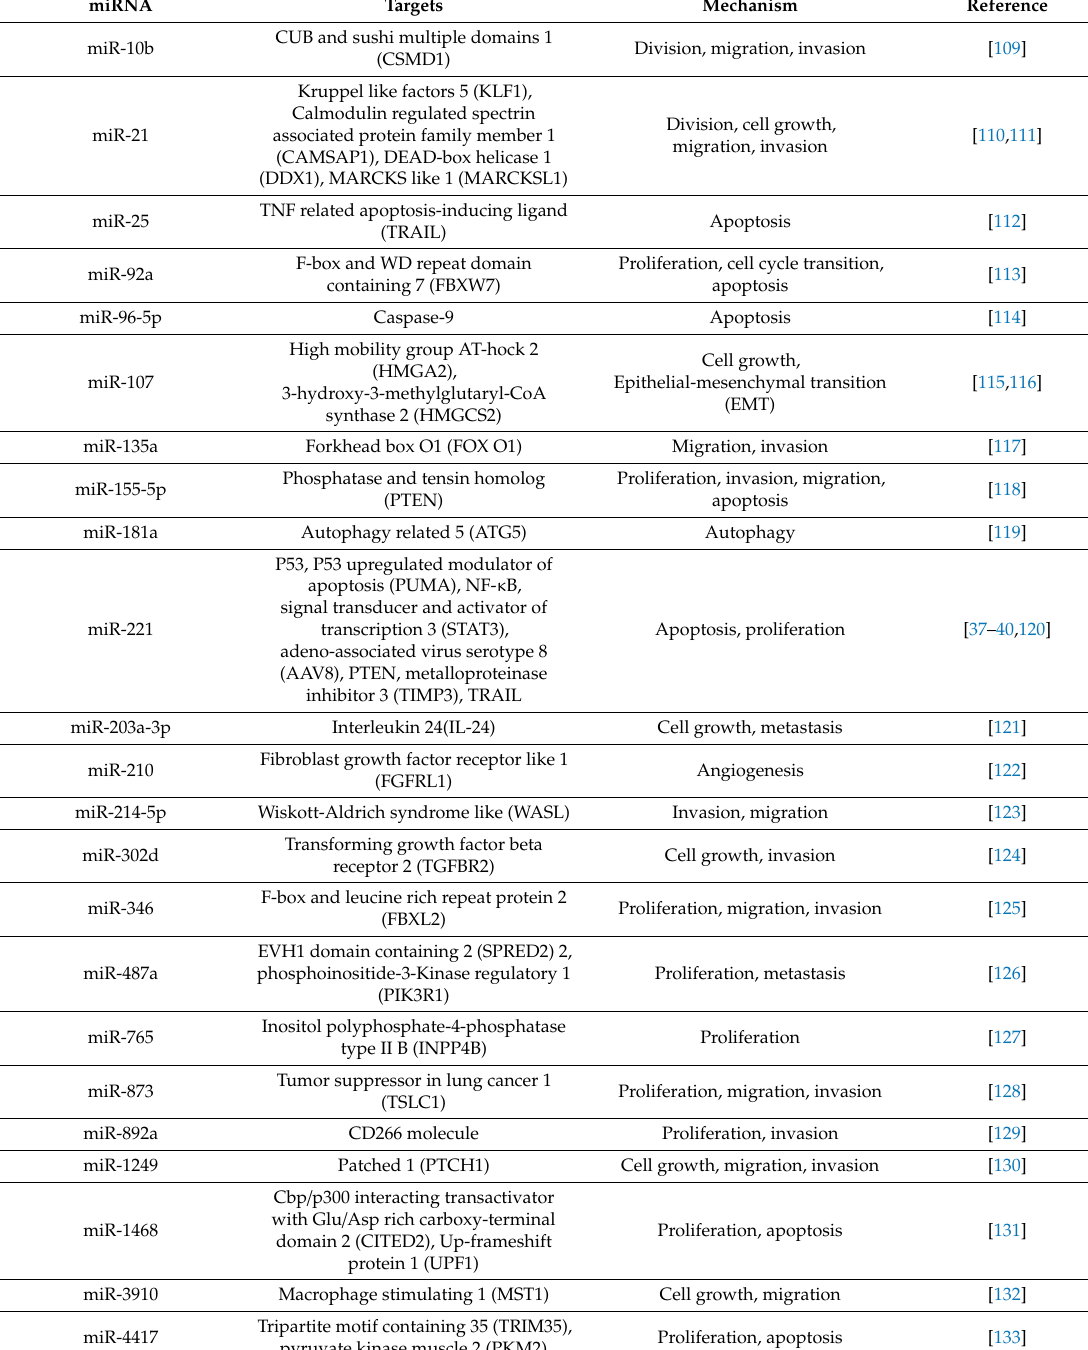
Table 2. Recently reported upregulated miRNAs acting as oncomiRs in hepatocellular carcinoma